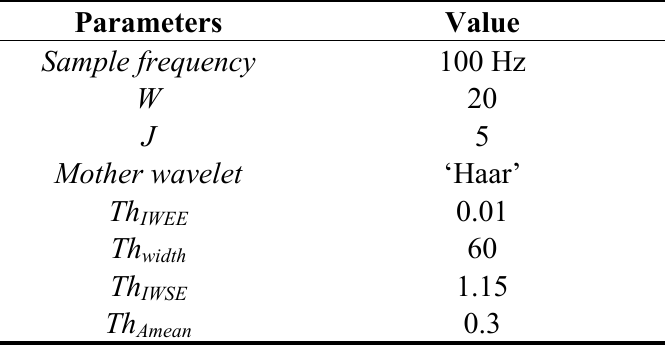
Table 2. Chosen parameters values for the experiments.